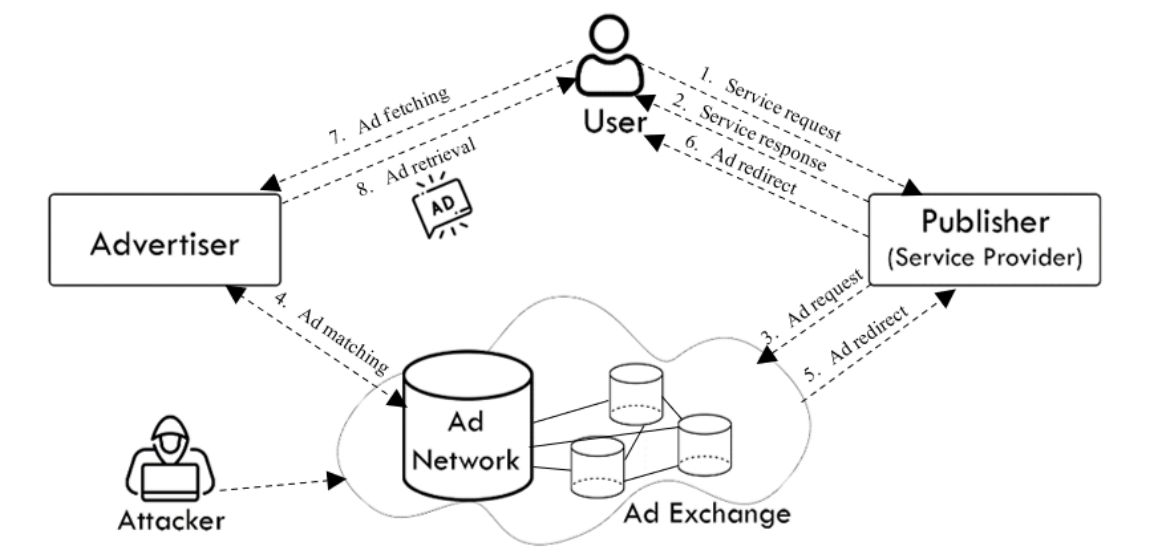
Figure 1. High-level architecture of online advertising.